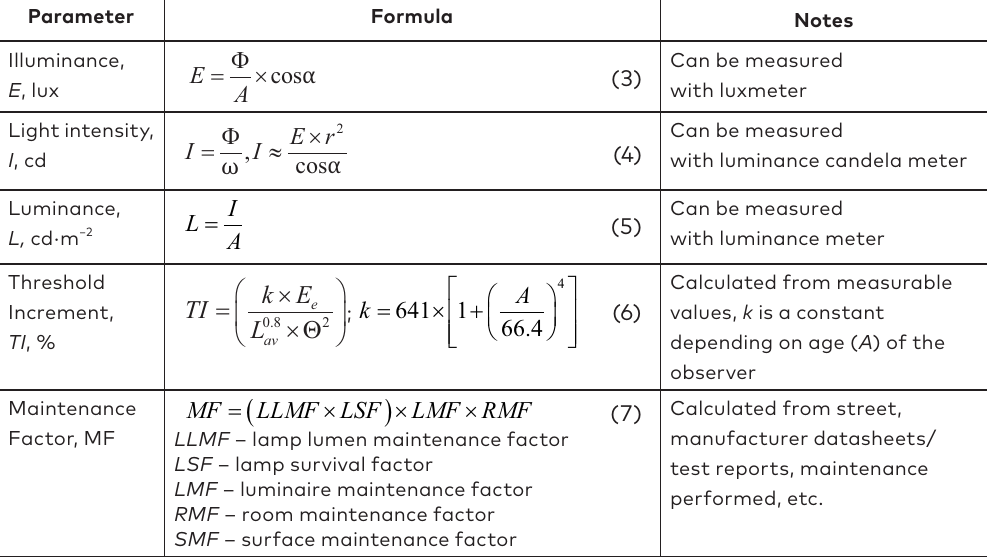
Table 1. The main lighting parameters describing safety performance of a road lighting